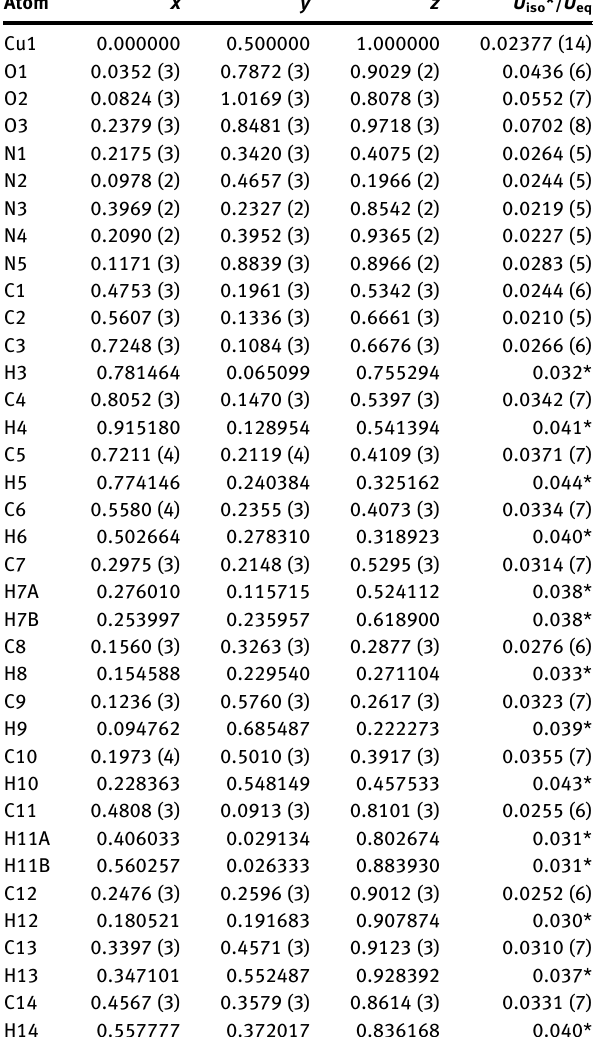
Table  : Fractional atomic coordinates and isotropic or equivalent isotropic displacement parameters (Å 